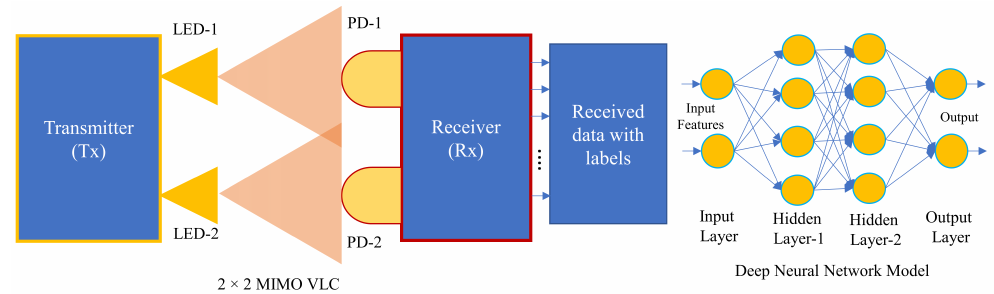
Figure 11. Machine Learning based VLC MIMO communication